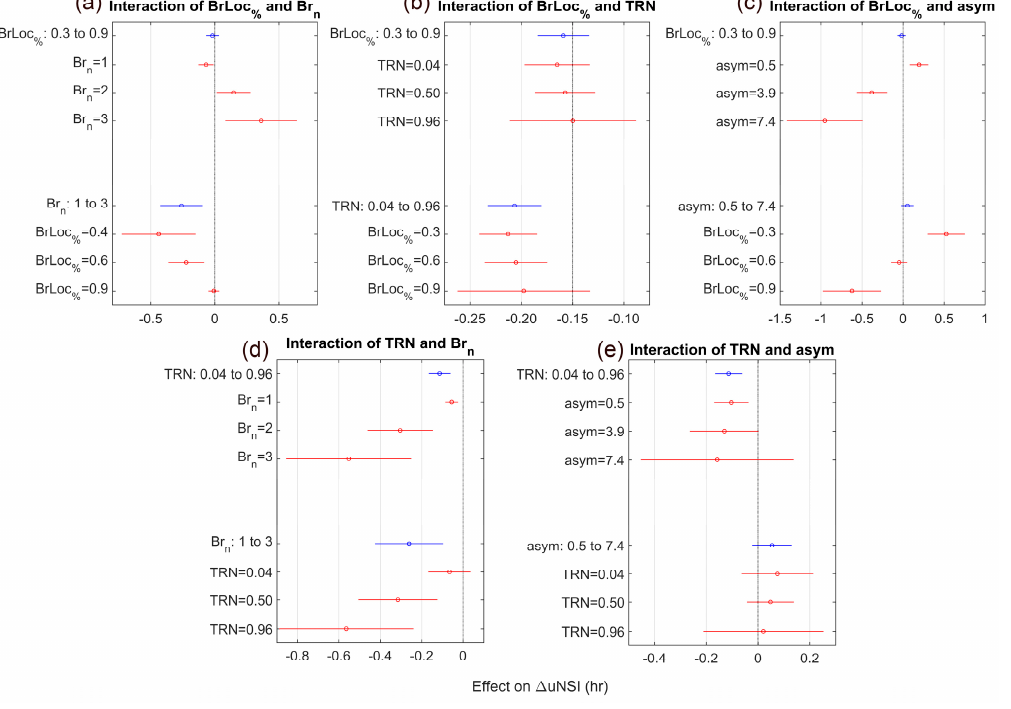
Figure 10. Estimated effects on ∆ uNSI of keeping one predictor fixed (percentage of the total storm period that has occurred at the start of the heaviest burst—BrLoc % , number of bursts—Br n , hyetograph triangularity—TRN, asymmetry of the storm—asym) while varying the other. The average effect is shown as a circle, while the horizontal bars are showing the confidence interval for the estimated effect. The blue symbols represent the overall average effect obtained by changing one predictor independently from the other, while the red ones represent the average effect achieved by changing one predictor over different values of the other one.